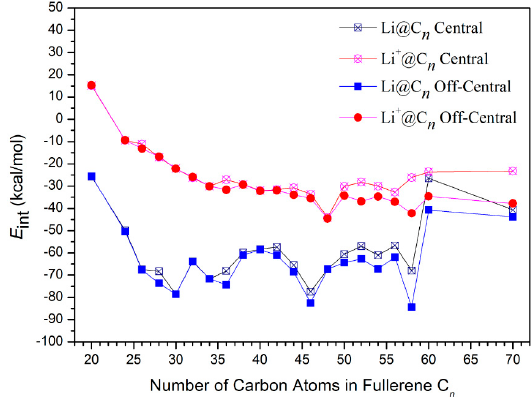
Figure 3. Interaction energies of Li@C n and Li + @C n.